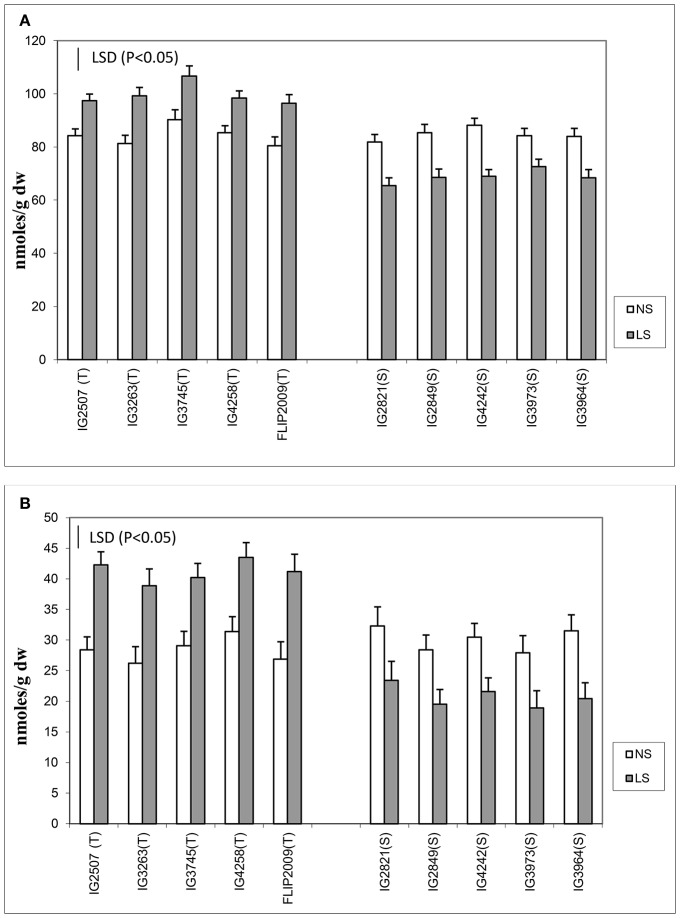
(A) Ascorbate (ASC) and (B) reduced glutathione (GSH) in normal-sown (NS) and late-sown (LS) genotypes. Small vertical bars on histograms represent standard errors. LSD (P < 0.05; represented as small vertical line close to y-axis) for ASC (4.7) and GSH (4.9); T, tolerant; S, sensitive.